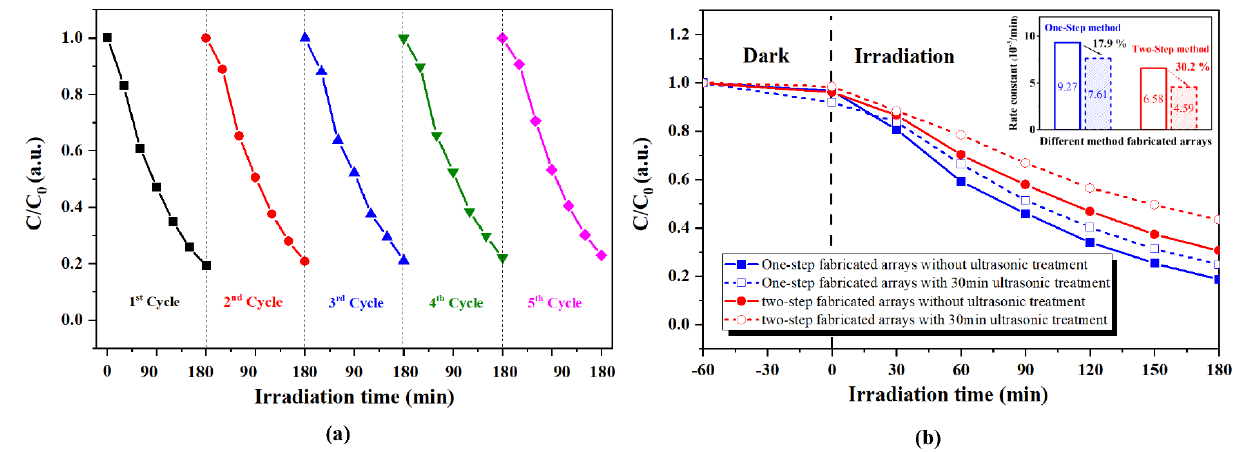
Figure 8. ( a ) Photocatalytic recycling test of supported nanosheet arrays ( b ) Comparison of photocatalytic durability test between one-step and two-step fabricated and supported nanosheet arrays.